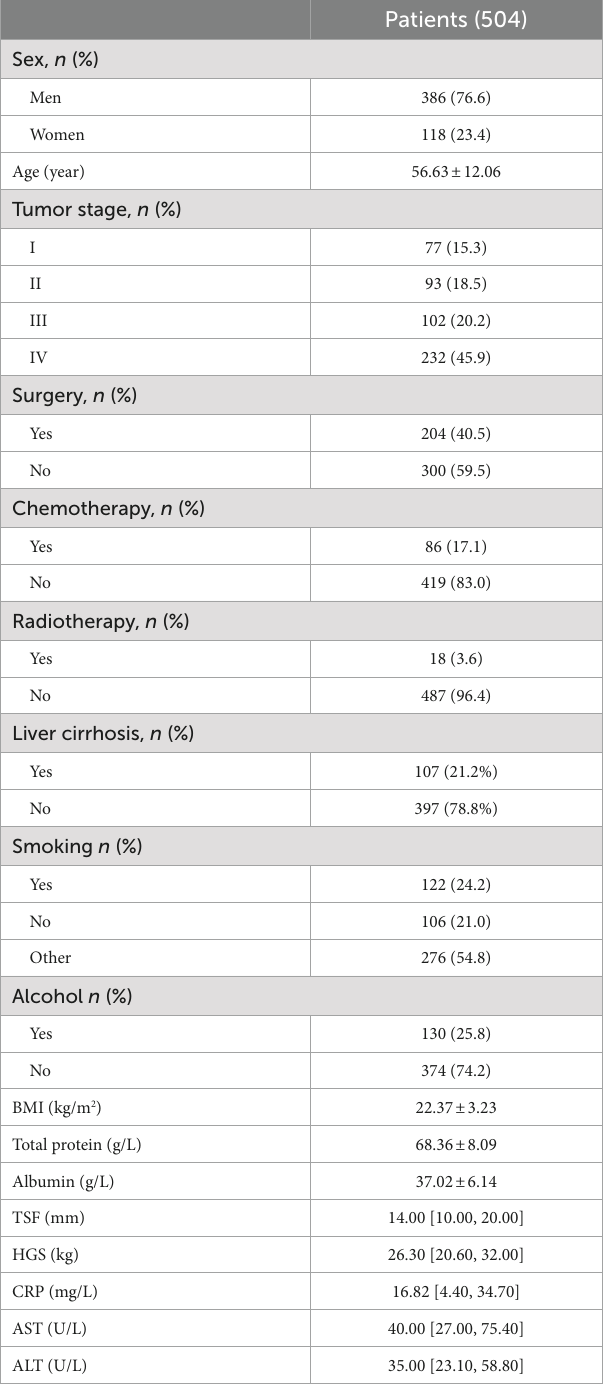
TABLE 1 Baseline characteristics of patients with liver cancer ( N =